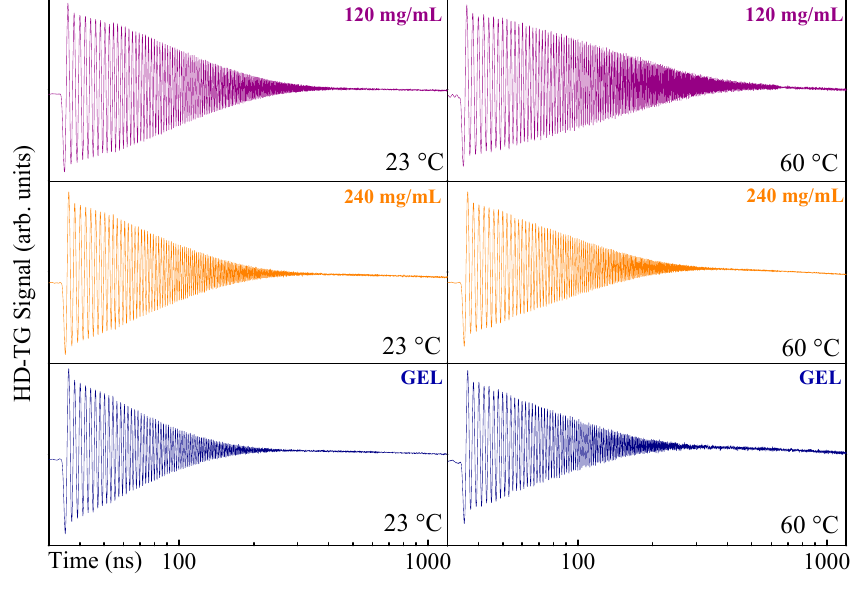
Figure 2. HD-TG decay signals for the wave vector q = 2.1 µm − 1 of: Hen egg white lysozyme (HEWL) 120 mg/mL solution (purple line), 240 mg/mL solution (orange line) and gel (blue line) at 23 °C (left panel) and 60 °C (right panel).